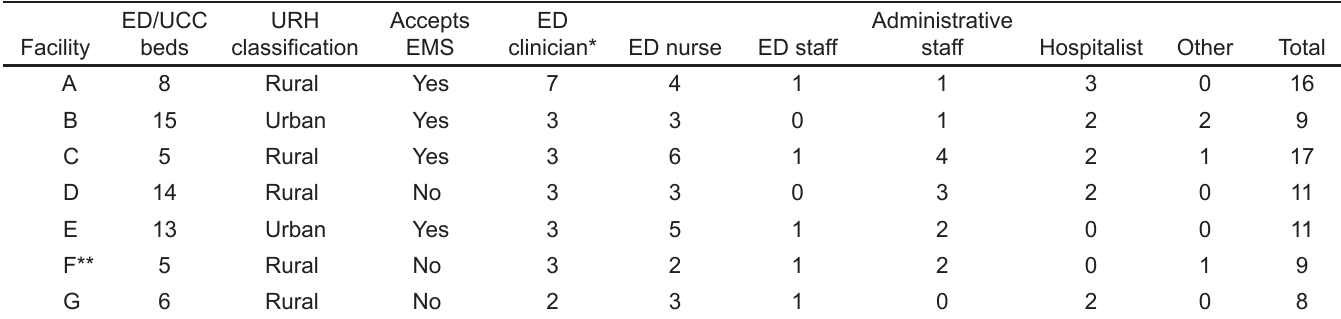
Table 1. Description of facilities and interviewees regarding the emergency department interfacility transfer